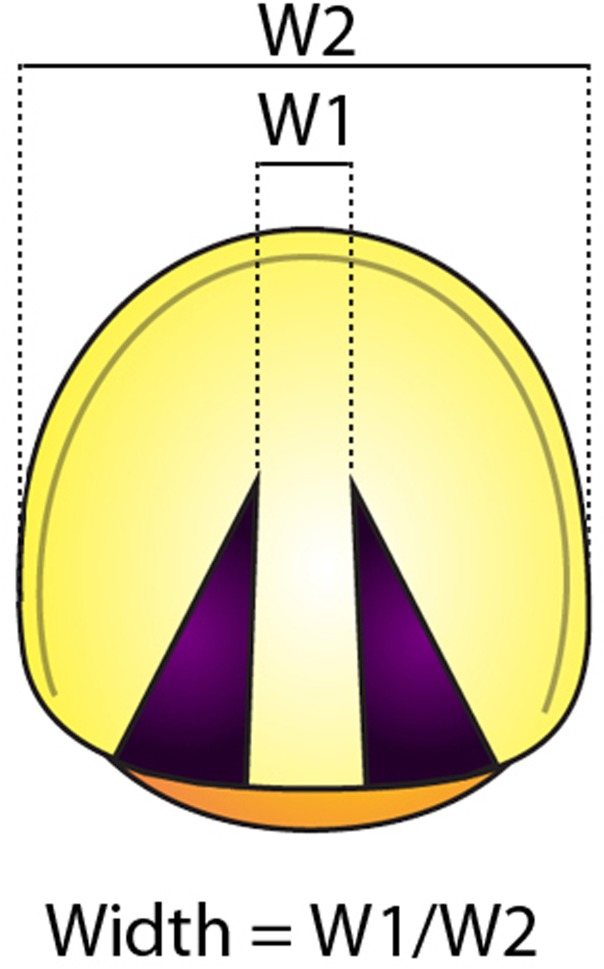
Measurement of the width.the width was obtained from the ratio between W1 (distance of the central gap in this case, or the expression domain) and W2 (the total width of the embryo).